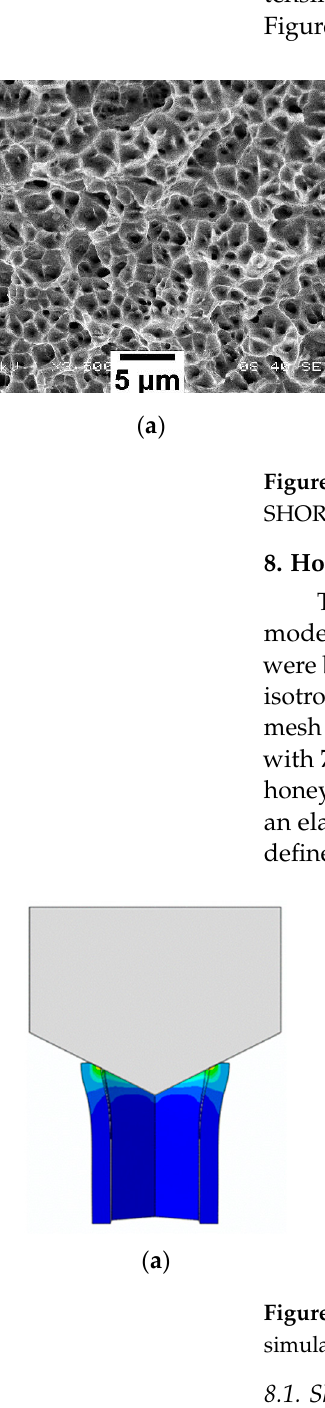
( b ) Figure 20. Records of honeycomb compression test: ( a ) force-punch displacement records for a